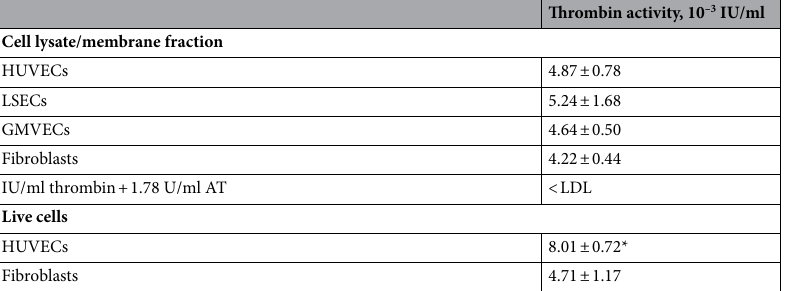
Table 1. Thrombin activity measurements. Thrombin activities were calculated from cleavage rates of a thrombin-specific chromogenic substrate and converted into IU/ml. The values shown (mean ± SD) were calculated from samples with thrombin activities above the lower detection limit (LDL) of the assay (3.8 (10 –3 ) IU/ml). Number of cell lysate samples with thrombin activities > LDL per total samples tested were HUVECs, 8/15; LSECs, 2/3; GMVECs, 3/3; and fibroblasts, 3/4. The thrombin activities measured in cell lysate/ membrane fractions were not significantly different in each cell type according to Dunn’s multiple comparison test. In the live cell measurements, the thrombin activities measured on live HUVECs were 1.7-fold higher than live fibroblast thrombin activities (*HUVECs versus fibroblasts p < 0.0001). The thrombin activities were measured on live HUVECs (n = 6), on live fibroblasts (n = 11), and in thrombin standards (n = 4). Antithrombin